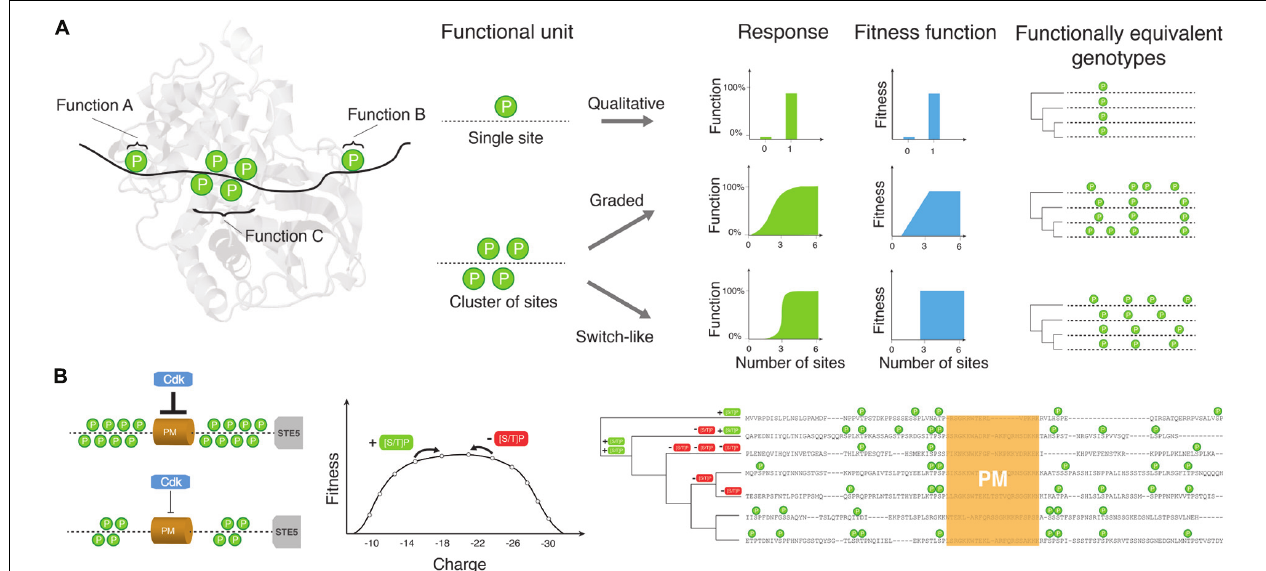
FIGURE 1 |The relationship between site phosphorylation, localization and protein functions determines how much conservation is expected among species under purifying or stabilizing selection. (A) Toy examples of phosphorylation sites (indicated as “P”s) and cluster of sites and how they may affect protein functions individually or collectively. Phosphorylation sites regulate three putative functions A, B, C. The aggregate function of phosphorylation sites affects the fitness function of the protein and thus determines how many possible equivalent genotypes may give rise to equivalent functions or fitness. Only few possible examples are shown to illustrate the complex relationships expected and their impact on the evolution of phosphorylation profiles and many more are possible. (B) Shows a possible fitness landscape for CDK inhibition